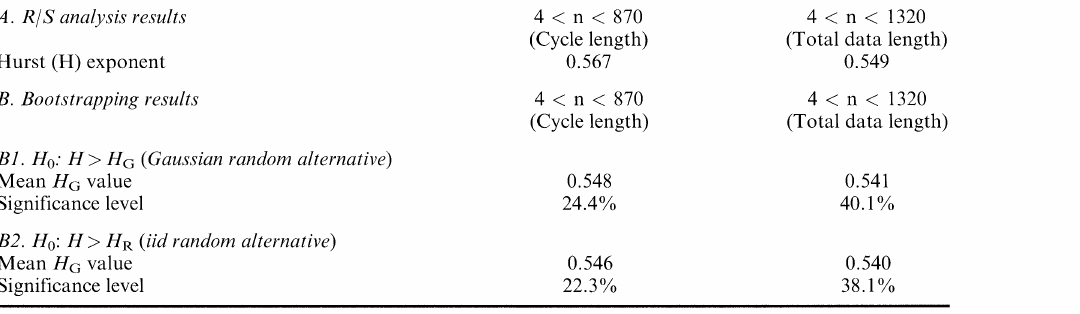
TABLE III Hurst estimates and test of significance against two random alternatives of the daily USD/ GRD returns